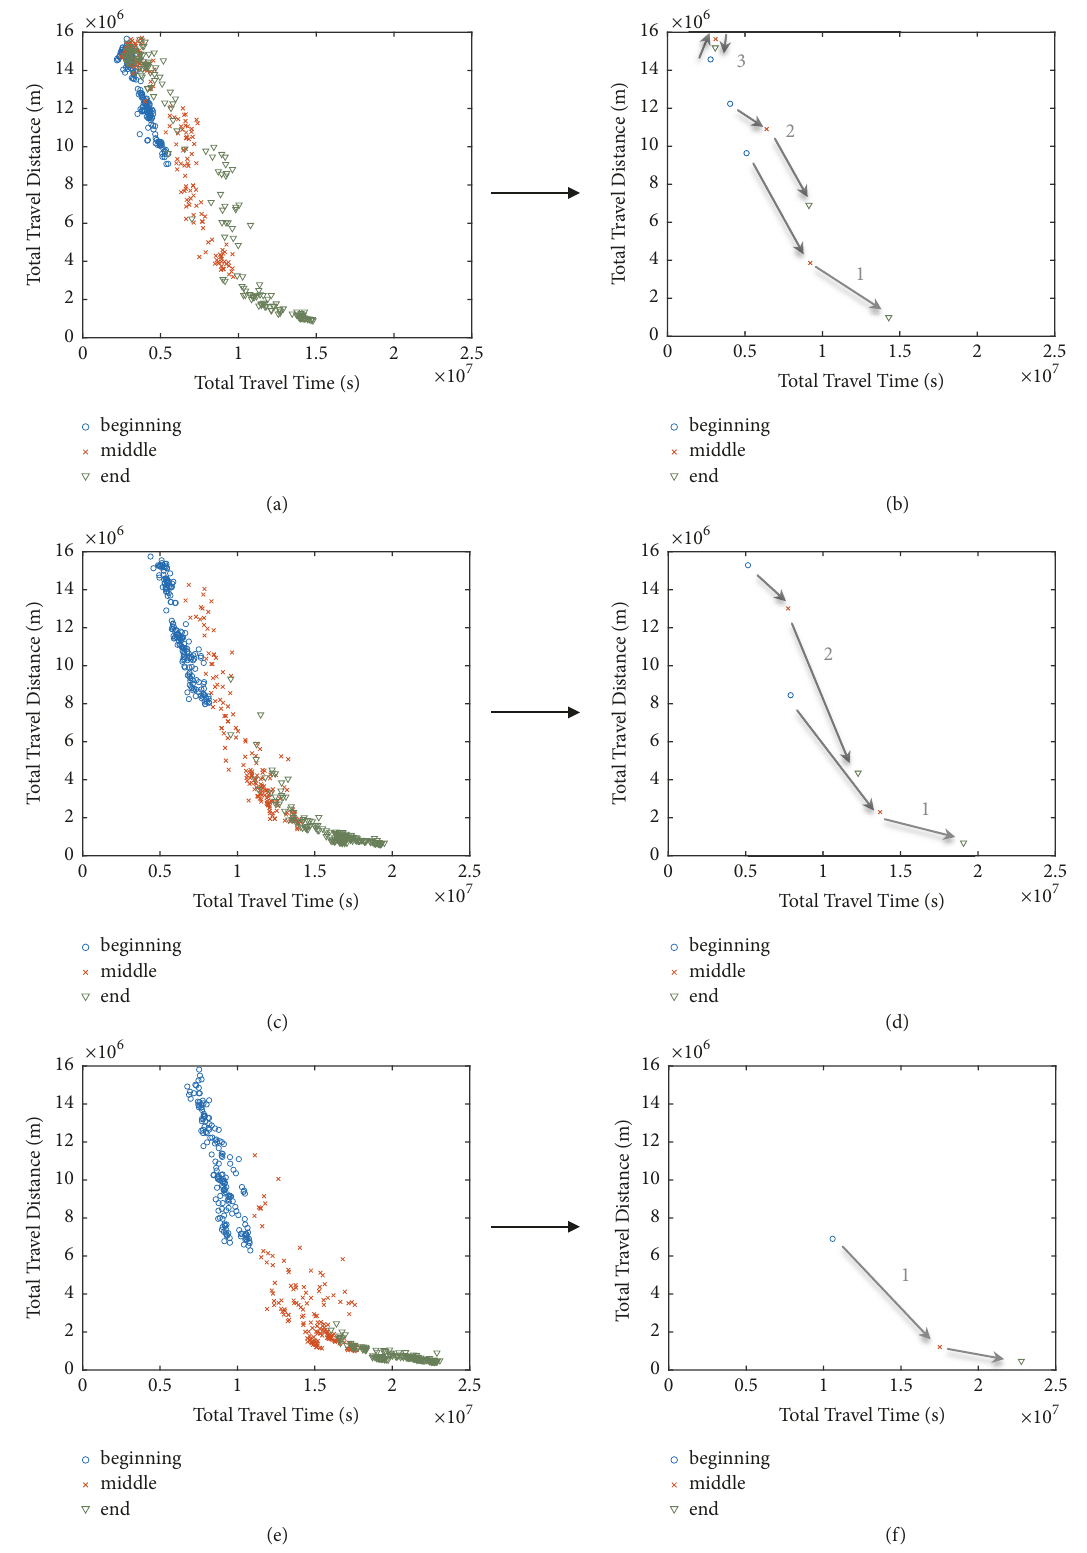
Figure 4: TTD performances: 1h30 simulations. Graphs (a), (c), and (e): evolution of all network states over time for demand levels 4, 5, and 6. Graphs (b), (d), and (f): some representative evolution cases for demand levels 4, 5, and